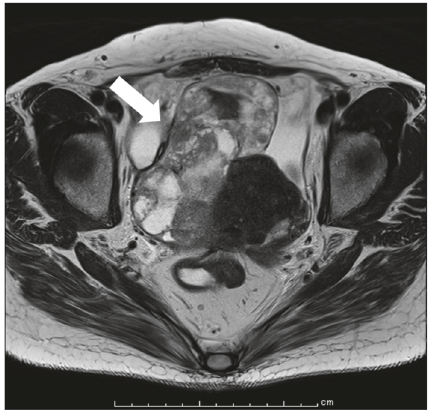
Figure 1: Pretreatment magnetic resonance imaging of our patient with endometriosis. Axial T1-weighted imaging at the first consul- tation. Two ovarian tumors (tumor size: right < left) show high- intensity signals (arrows), and the internal structure shows a blood- resistant component.